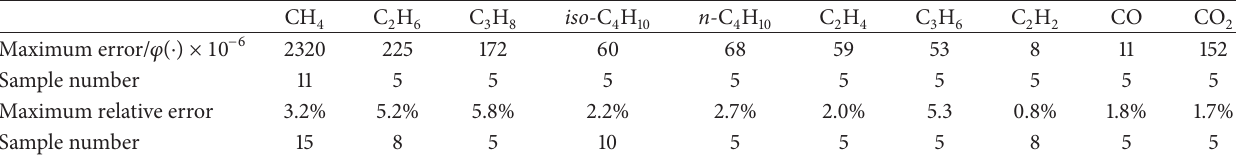
Table 5: The maximum absolute error and the maximum relative error of every component analysis